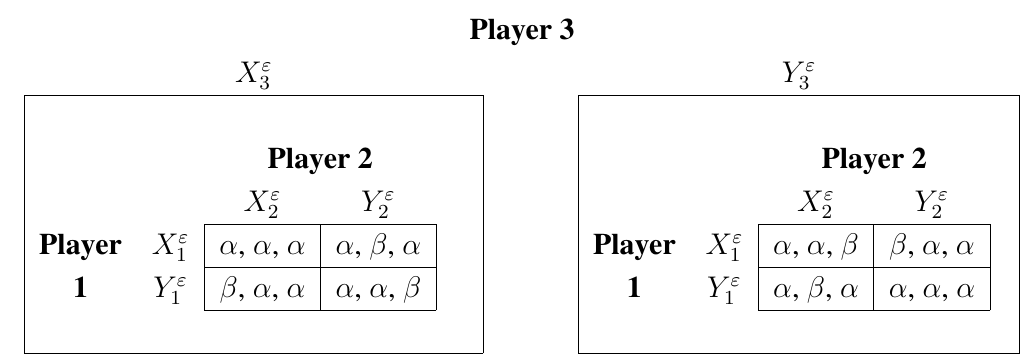
Table 4. The ε -uniformly perturbed minority of three-game in normal